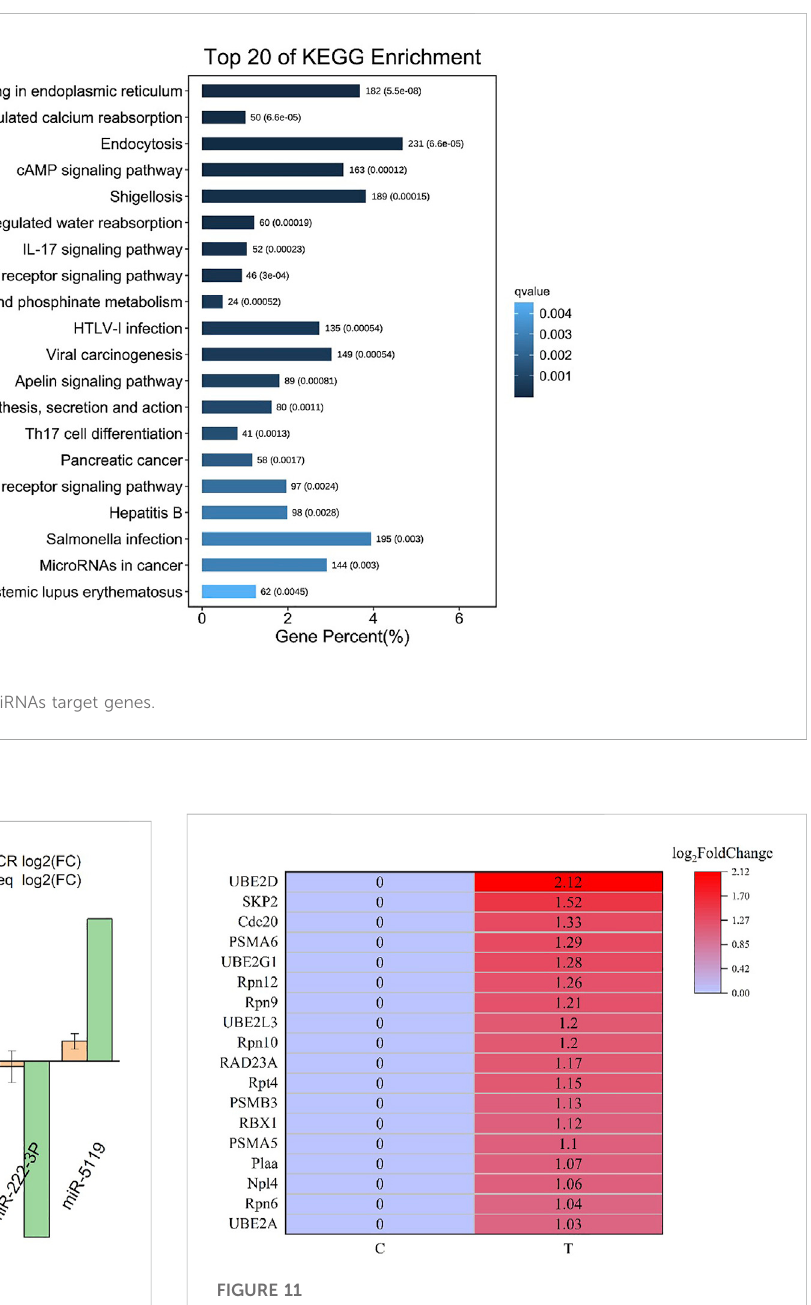
Heat mapof DEGs involved inthedegradationof misfolded protein in